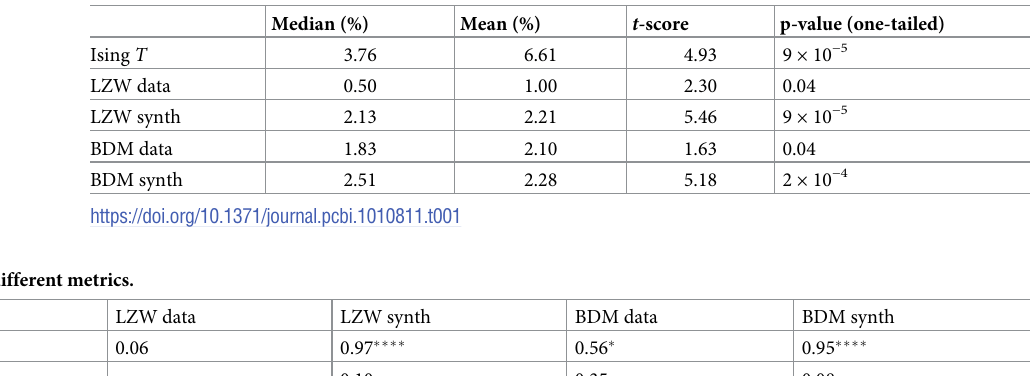
Table 1. Summary statistics of different metrics. Change in Ising temperature and complexity metrics in the LSD condition relative to the Placebo